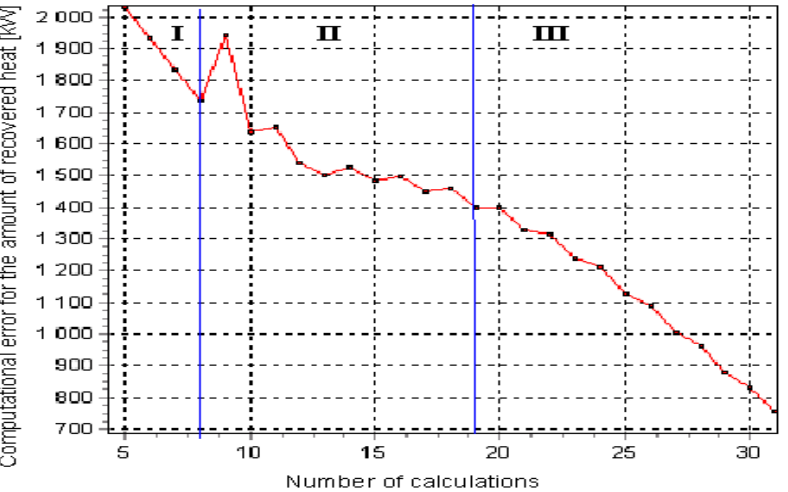
Figure 7. Stages of determining the amount of heat absorbed in the exhaust gas boiler.